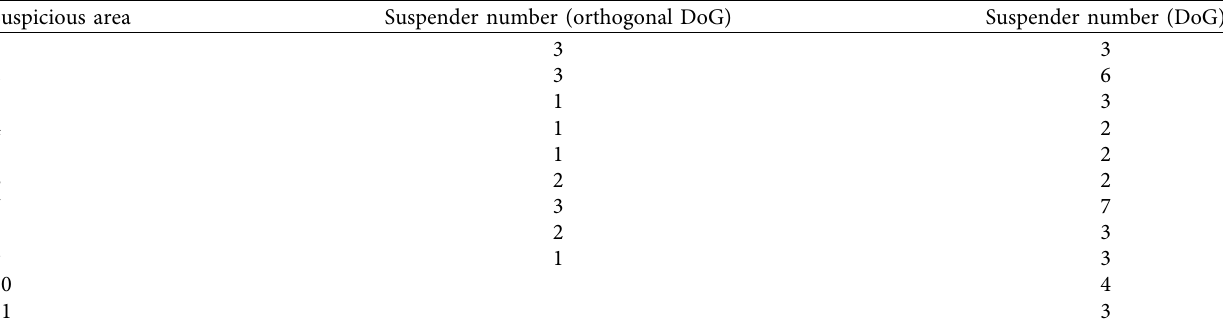
Table 2: The number of suspenders contained in each suspicious short circuit area.